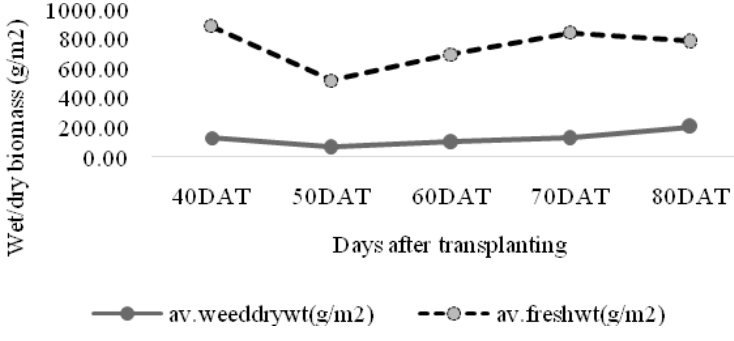
Figure 6: Weed biomass in different time